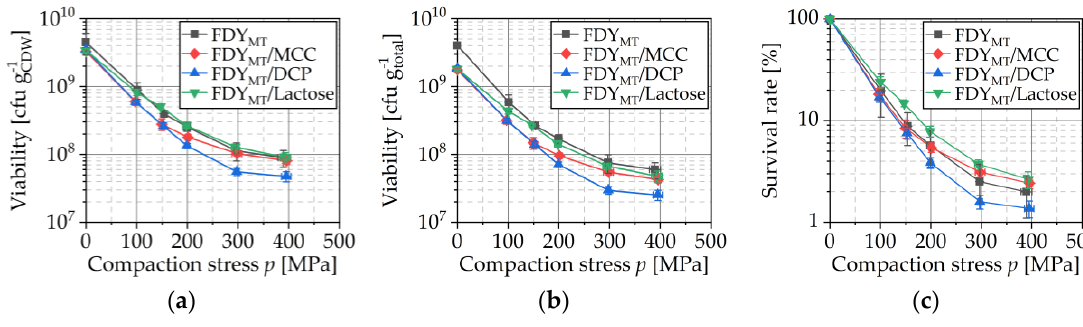
Figure 4. Effect of compaction stress on viability related to the cell dry weight ( a ) and total mass ( b ) as well as on the survival rate ( c ). Freeze-dried yeast cells with 15% milk powder and 25% trehalose as cryoprotectants (FDY MT ) without further excipients and mixed with MCC, DCP and lactose were compacted. Symbols represent means and error bars standard deviation; n = 3.